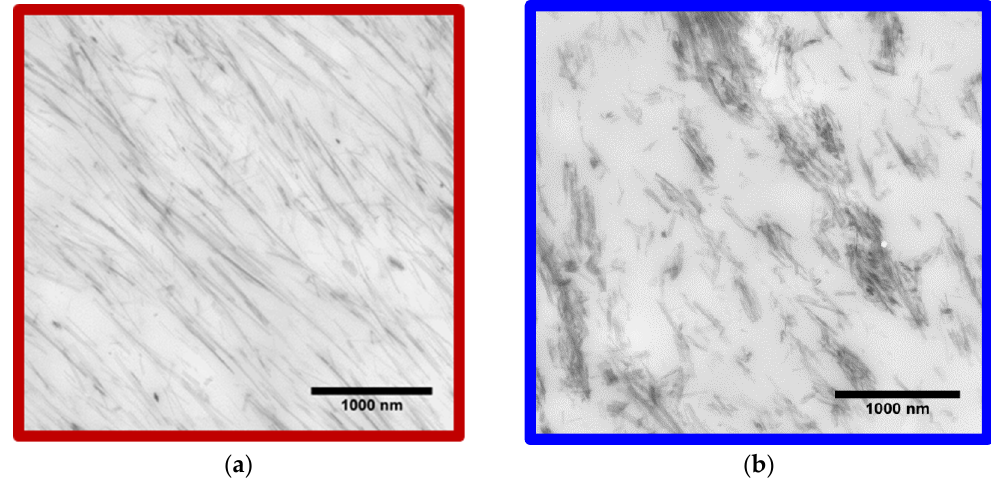
Figure 3. ( a ) Organomodified sepiolite (Pangel B5) as a single filler in rubber compound; ( b ) Smart-net Silica ® featuring stronger interparticle attraction. From ref. [35].